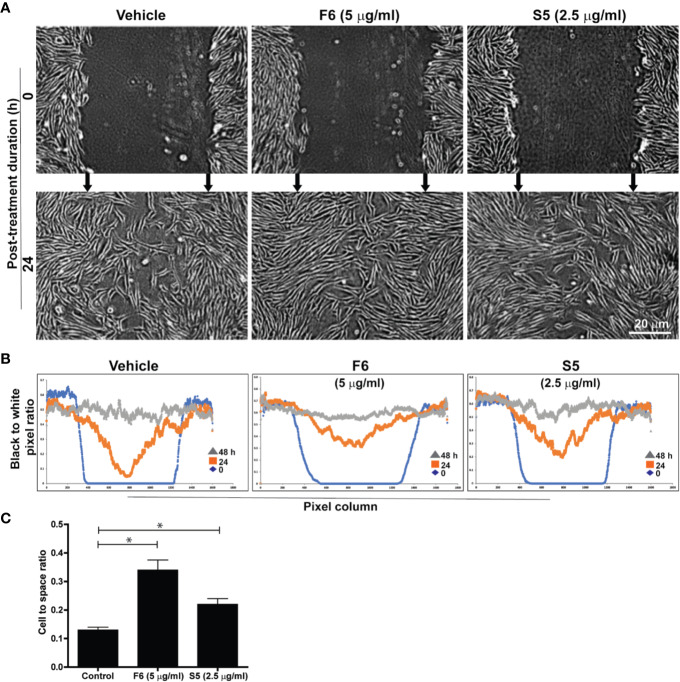
F6 and S5 promote fibroblast migration into the scratch wound, ex vivo. Assessment of migration of fibroblasts into a midline gap evoked by incubation with furan fatty acid F6 and the steroid S5 at indicated doses. (A) photographs of the midline gaps in the presence of the two compounds (S5 or F6 and their vehicle control) at gap initiation (0 h) and 24 h following incubation. Photographs show the transparent cells on a dark background with manual integration. (B) the number of cells infiltrated into the gap after 0, 24, and 48 h from binarized images using an automated segmentation and quantification program designed to measure black-to-white (B/W) pixel ratio (based on similar images shown on panel A). Blue lines represent the B/W pixel ratios for the 1600 columns of the images taken immediately following monolayer disruption (0 h). The red and grey lines describe the B/W pixel ratios for the 1600 columns of the images taken 24 h and 48 h following monolayer disruption, respectively. (C) Quantitative analyses of the data at 24 h in terms of cell to space ratio, show the fibroblast migration into the scratch wound (n = 3-4, p < 0.05; *, significantly different compared to the control).